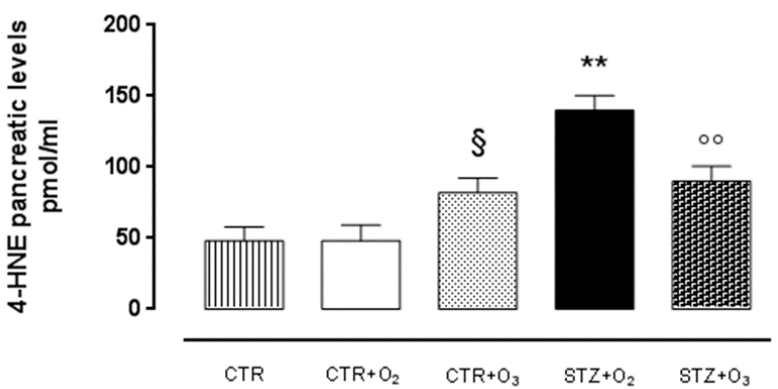
Figure 2. 4-HNE pancreatic levels. ELISA test results of 4-HNE pancreatic levels (pmol/mL ± s.e.m.), after one week of STZ: ozone-treated STZ rats show a significant reduction in pancreatic 4-HNE levels compared to O 2 -treated STZ rats ( p < 0.01). CTR = saline-treated rats; CTR + O 2 = oxygen-treated rats; CTR + O 3 = ozone-treated rats; STZ + O 2 = oxygen-treated STZ rats; STZ + O 3 = ozone-treated STZ rats. Results are the mean ± s.e.m. of five experiments. § p < 0.05 vs. CTR + O 2 ; ** p < 0.01 vs. CTR + O 3 ; °° p < 0.01 vs. STZ + O 2 .